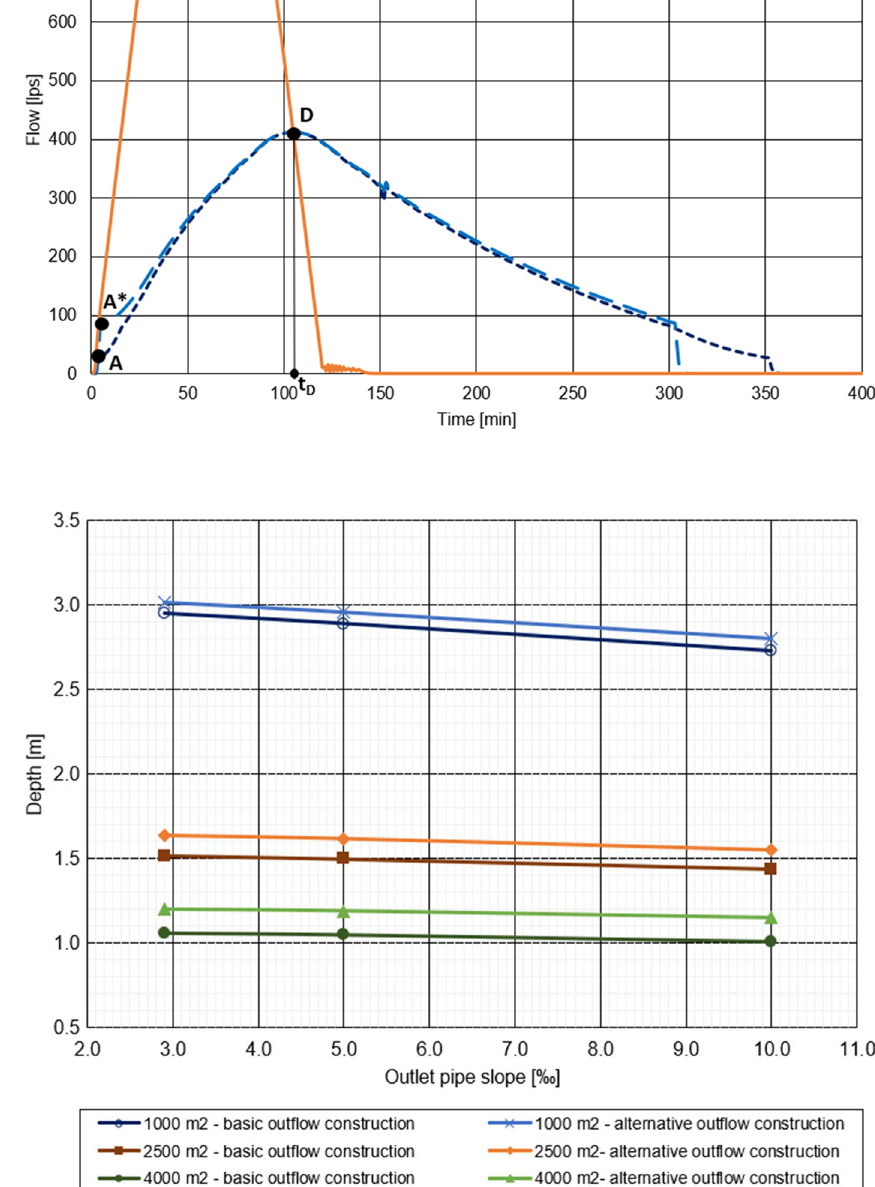
Fig. 7 Another example of the inflow and two different outflows from the tank as a function of time. Bottom tank area in the alternative ver‑ sion was adjusted to gain the same maximum outflow values (D‑point)